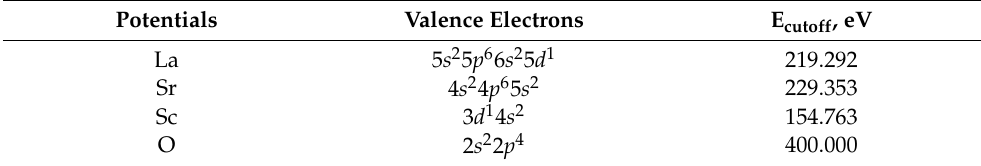
Table 2. Projector Augmented Wave (PAW) [20] Perdew-Burke-Ernzerhof (PBE) [21] potentials for core